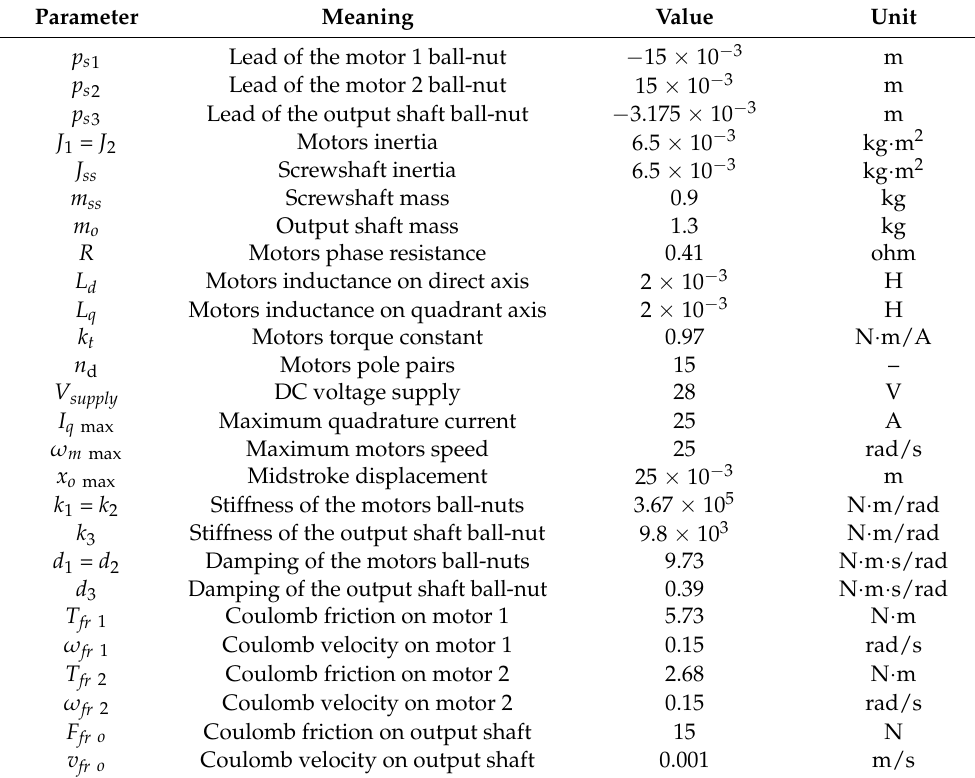
Table 6. Parameters of the electro-mechanical section of the model. Parameter Meaning